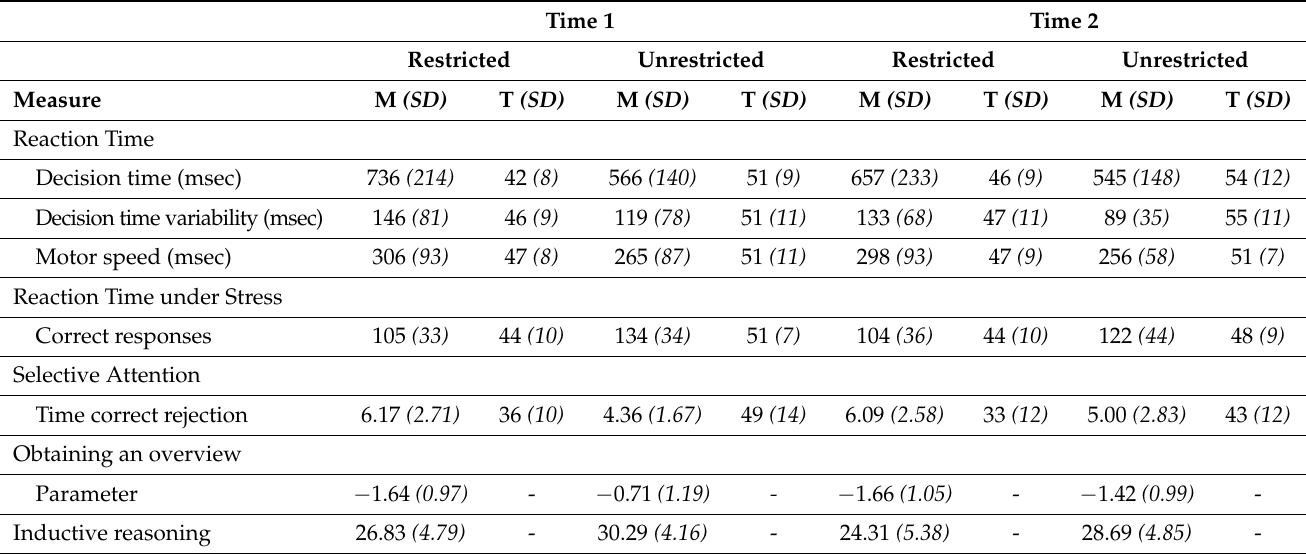
Table 1. Descriptive statistics (means and standard deviations) and T scores.